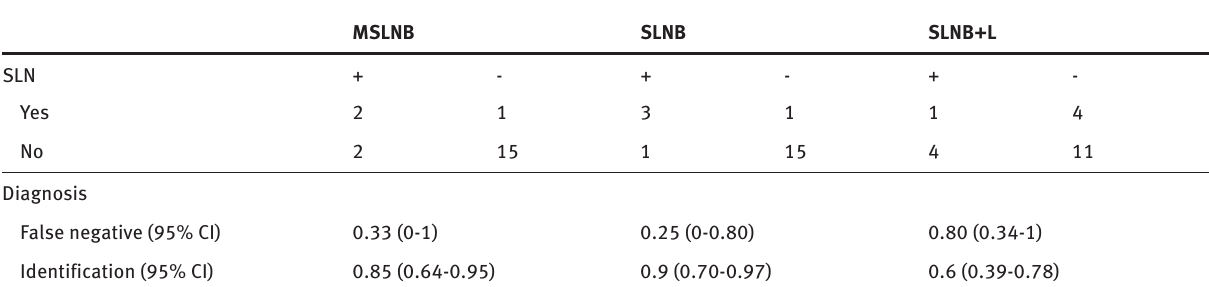
Table 3: Diagnosis accuracy of SLN among the three surgery